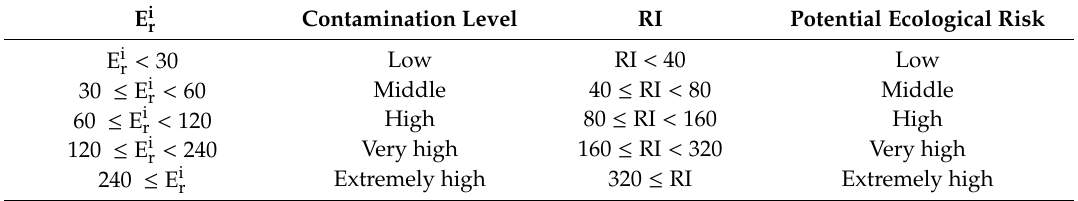
Table 4. Adjusted grading standard of potential ecological risk of heavy metals in soil [41].